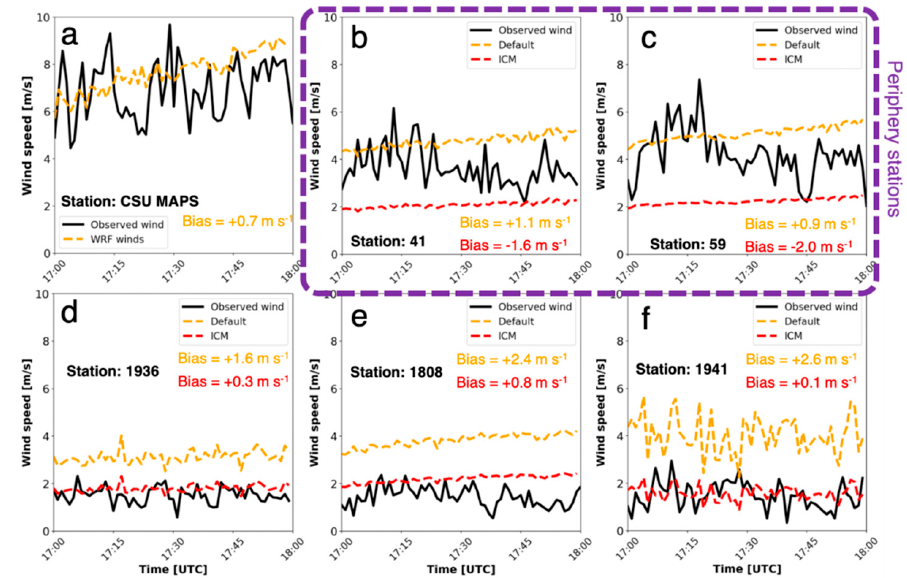
Figure 4. Wind comparisons at six wind measurement sites near or within the L2F burn plot between 17:00–17:59 UTC on 11 November 2012. The black line represents measured wind speeds, while the orange line represents WRF modeled wind winds interpolated to the measurement height location. The red line represents WRF estimated wind speeds that were adjusted by the ICM parameterization. Panel ( a ) shows wind comparisons at 31-m for the CSU-MAPS tall tower, while panels ( b )–( f ) are comparisons at the 3-m anemometer